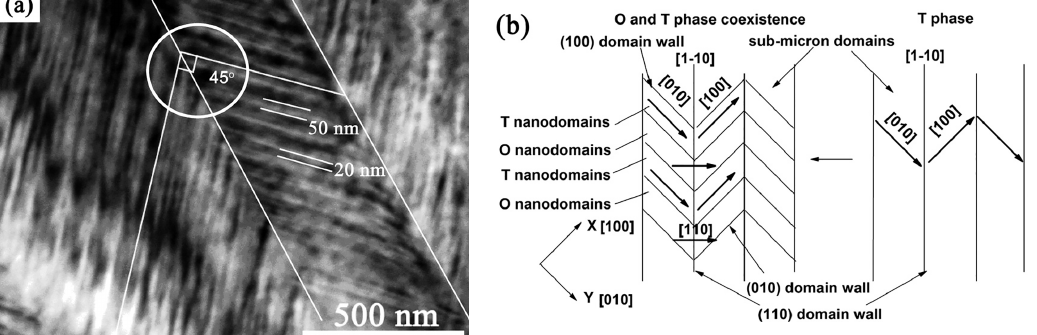
Figure 12. ( a ) Bright-field image of NKNS-0.0375LT ceramic sample; ( b ) Scheme of domain morphology evolution from single T phase to coexisted O and T phases. Adapted from [121], with permission from © 2011 AIP Publishing LLC.